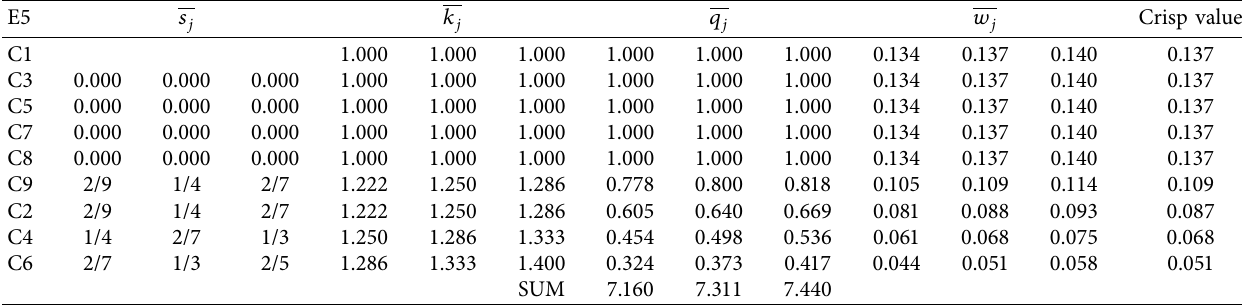
Table 7: Calculation and values of weight coefficients obtained by the IMF SWARA method for